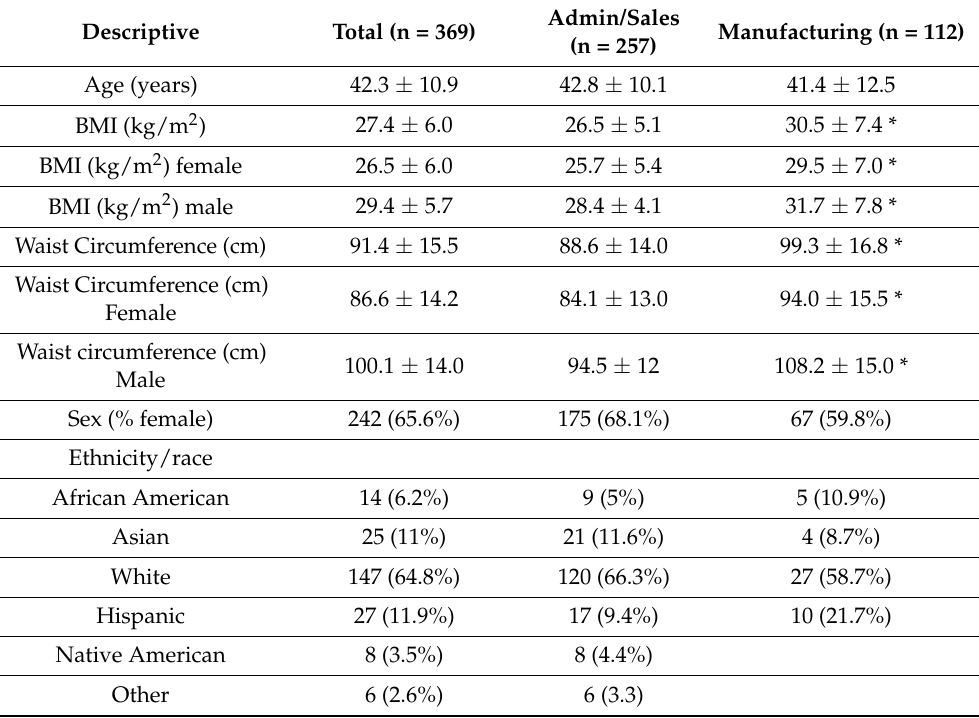
Table 3. Baseline Characteristics of Participants of the LIFEHOUSE Design Survey; Age, Body Mass Index (BMI), Waist Circumference,